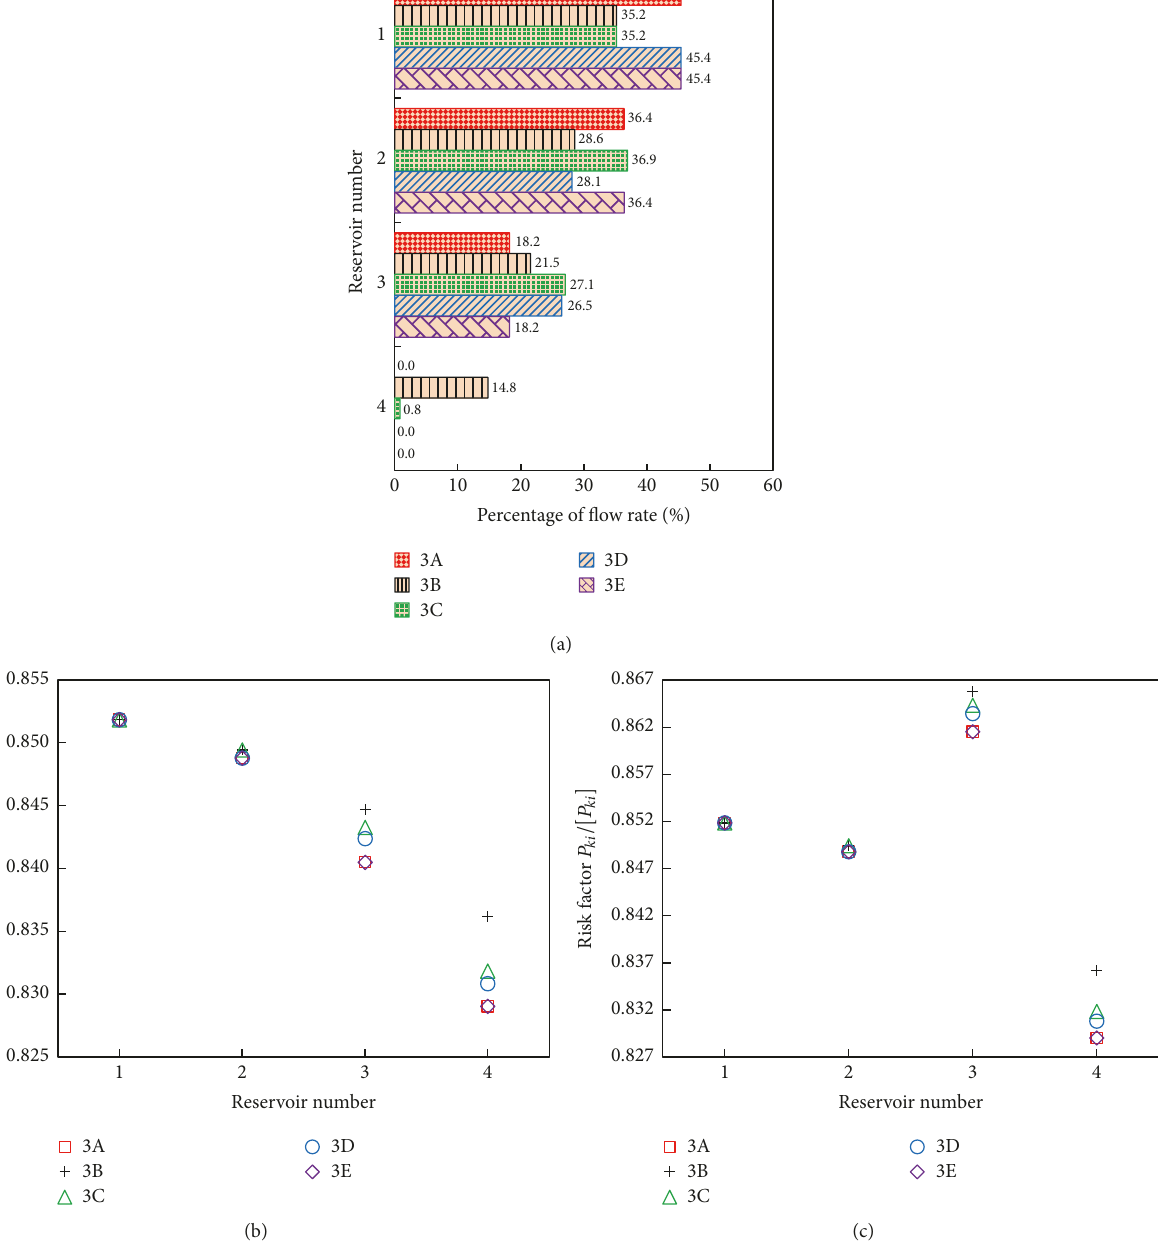
Figure 7: Proportions of the inflows (a) and risk factors of each reservoir under different initial formation pressures for the two scenarios of the conceptual engineering model. (b) and (c) are the risk-factor results for Scenarios S-1 and S-2,